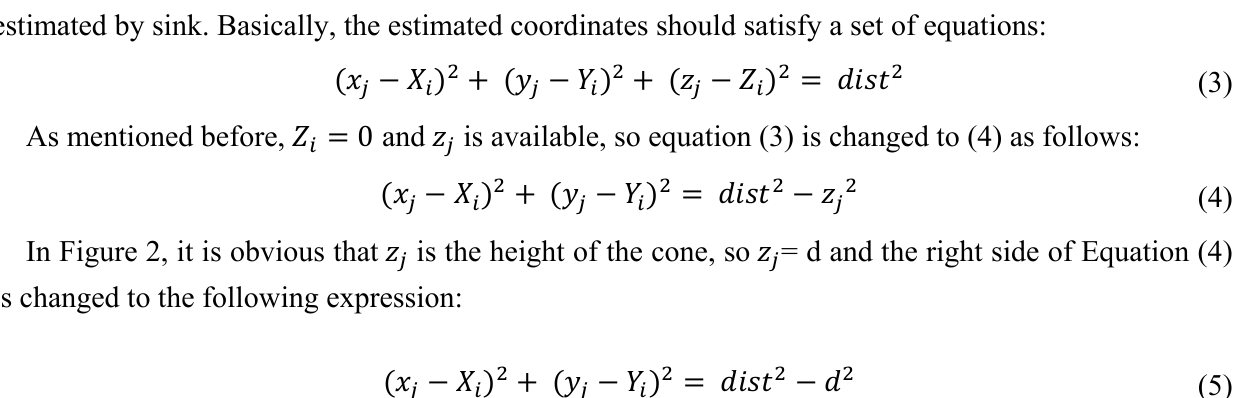
Figure 5. After receiving the anchor message in sink, (cid:1856)(cid:1861)(cid:1871)(cid:1872) (cid:4666)(cid:1861), (cid:1862)(cid:4667) is defined